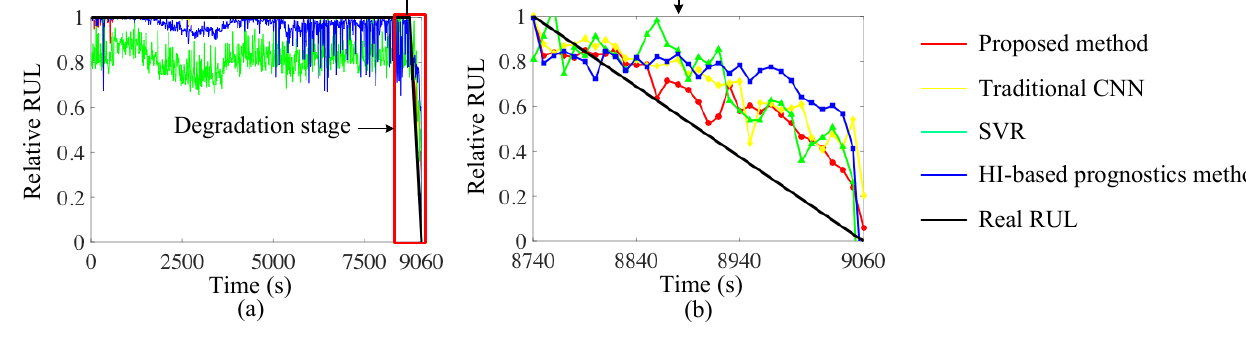
Figure 9. ( a ) RUL prediction results of the proposed method, traditional CNN method, SVR and HI-based prognostics method; and ( b ) their enlargement. The red line represents the result of the proposed method; the yellow line represents the traditional CNN method; the green line represents the SVR result; the blue line represents the HI-based method and the black line represents the real